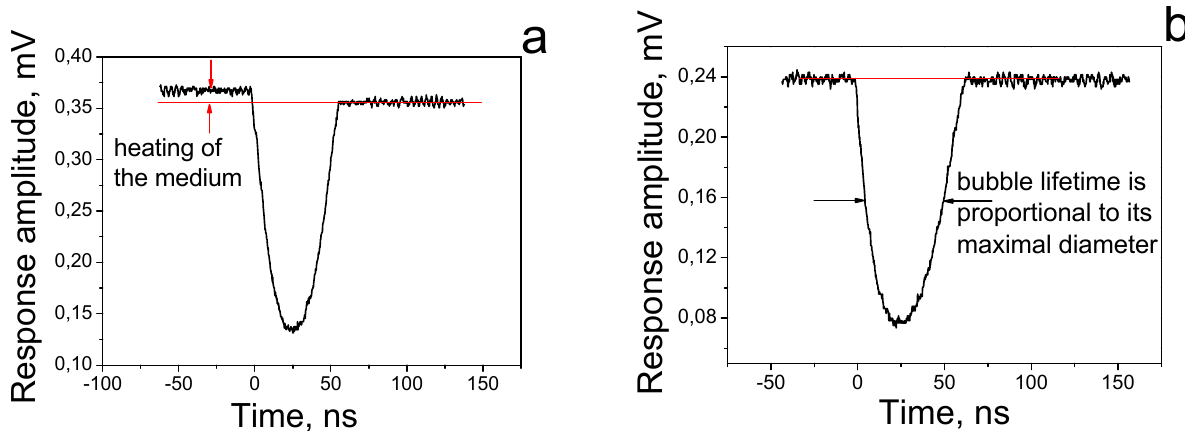
Figure 2. Time responses of the probe laser signal to single excitation laser pulses: ( a ) light-absorbing molecular solution generates the vapor bubble and residual heating of the environment (shown with two red arrows); ( b ) plasmonic (gold) NP generates the vapor bubble (PNB) without any environmental thermal effects after the collapse of the PNB. Red line shows the background